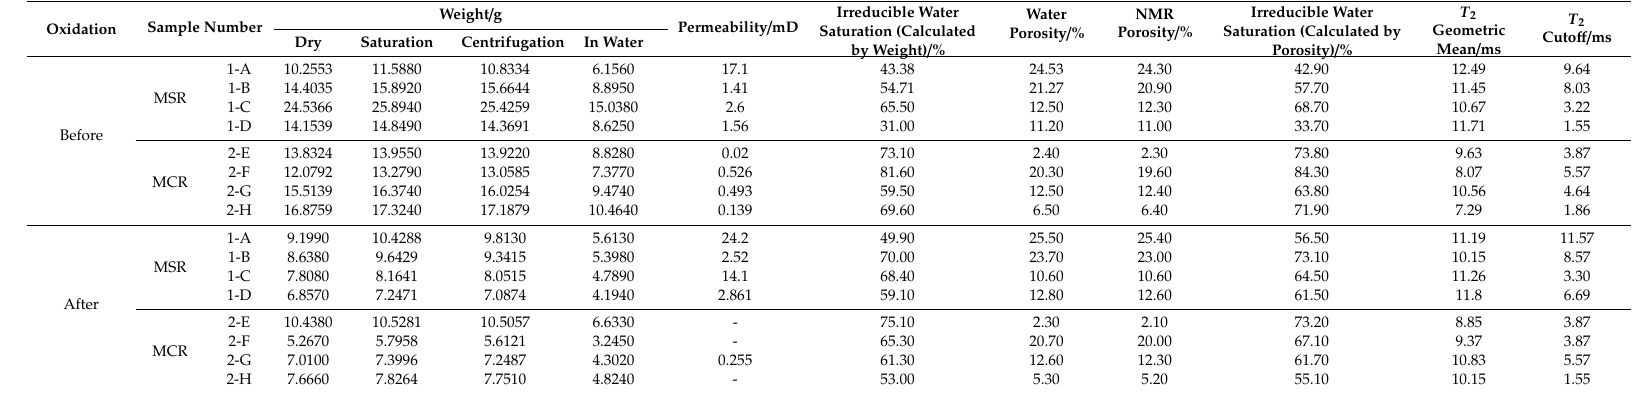
Table 1. NMR experimental parameter of the selected mixed siliciclastic-carbonate rocks.